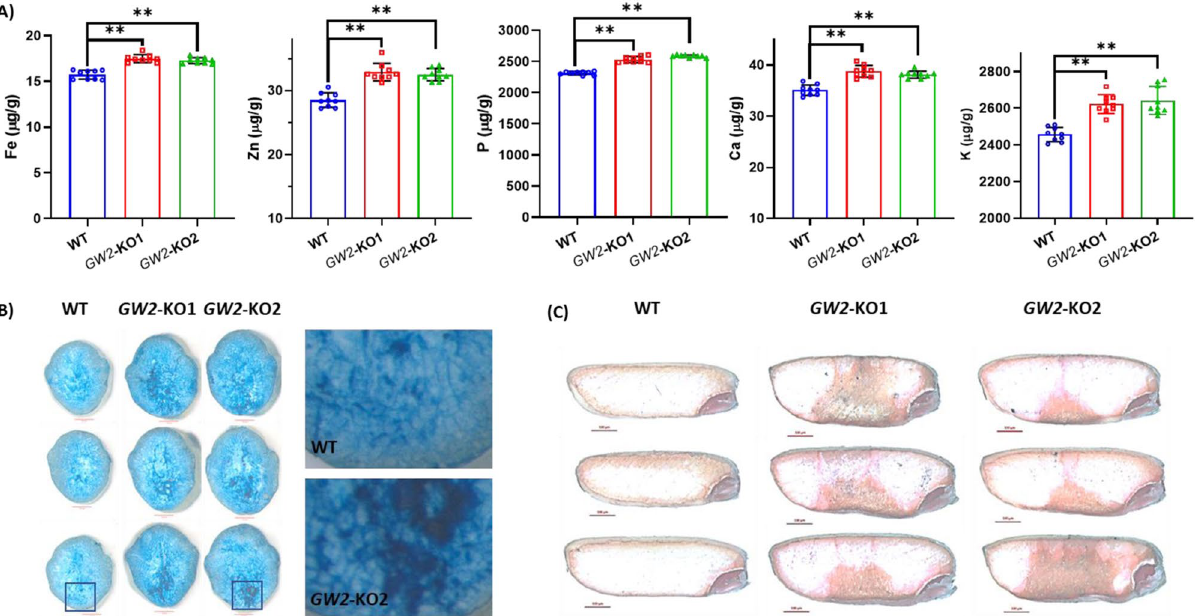
Figure 3. Assessment and distribution of grain mineral content. ( A ) ICP-MS quantification mineral content (Fe, Zn, P, Ca and K) in the mature dehusked rice seeds. The seed iron (9–11%), zinc (13–15%), phosphorus (9–11%), calcium (8–10%) and potassium (6–7%) content were significantly p ≤ 0.01 (**) increased in the GW -KO rice lines. Data ± SD (n = 9). ( B ) The transverse cut section showing variation in the Prussian blue stain intensity among WT and GW2 -KO lines. The GW2 -KO lines accumulates improved iron content in the rice endosperm compared to WT seed. Scale bar 50 µm. ( C ) The dithizone stained longitudinally cross section of half seed form WT and GW -KO lines showing different degrees of zinc deposition. The GW -KO lines accumulates higher amount of zinc metal in the endosperm tissue compared to WT seed. Scale bar 100 µm. Microscopy was performed using Carl Zeiss stereoscopic zoom microscope (Discovery V8) attached with cooled digital